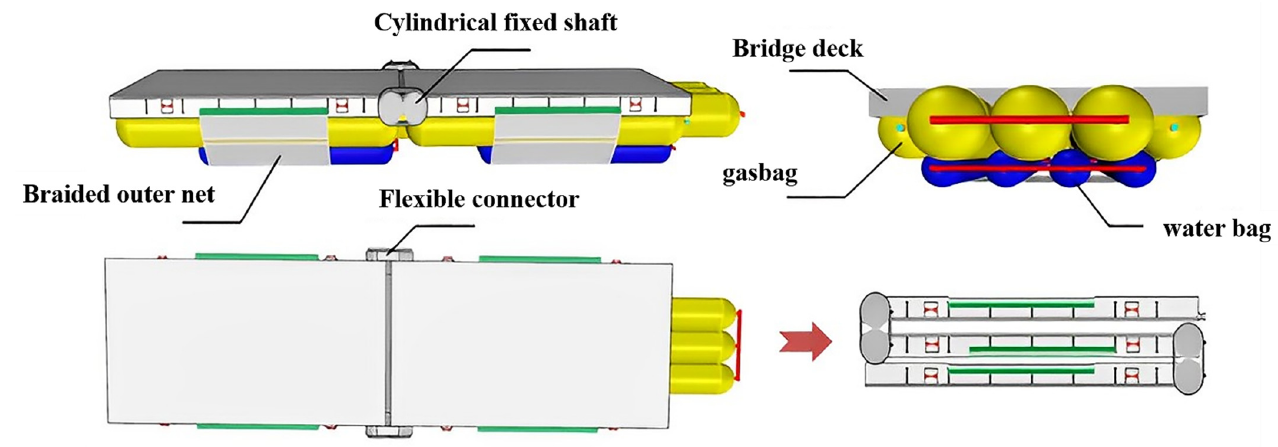
Figure 1. The overall structural design of the rigid-flexible folding floating bridge.